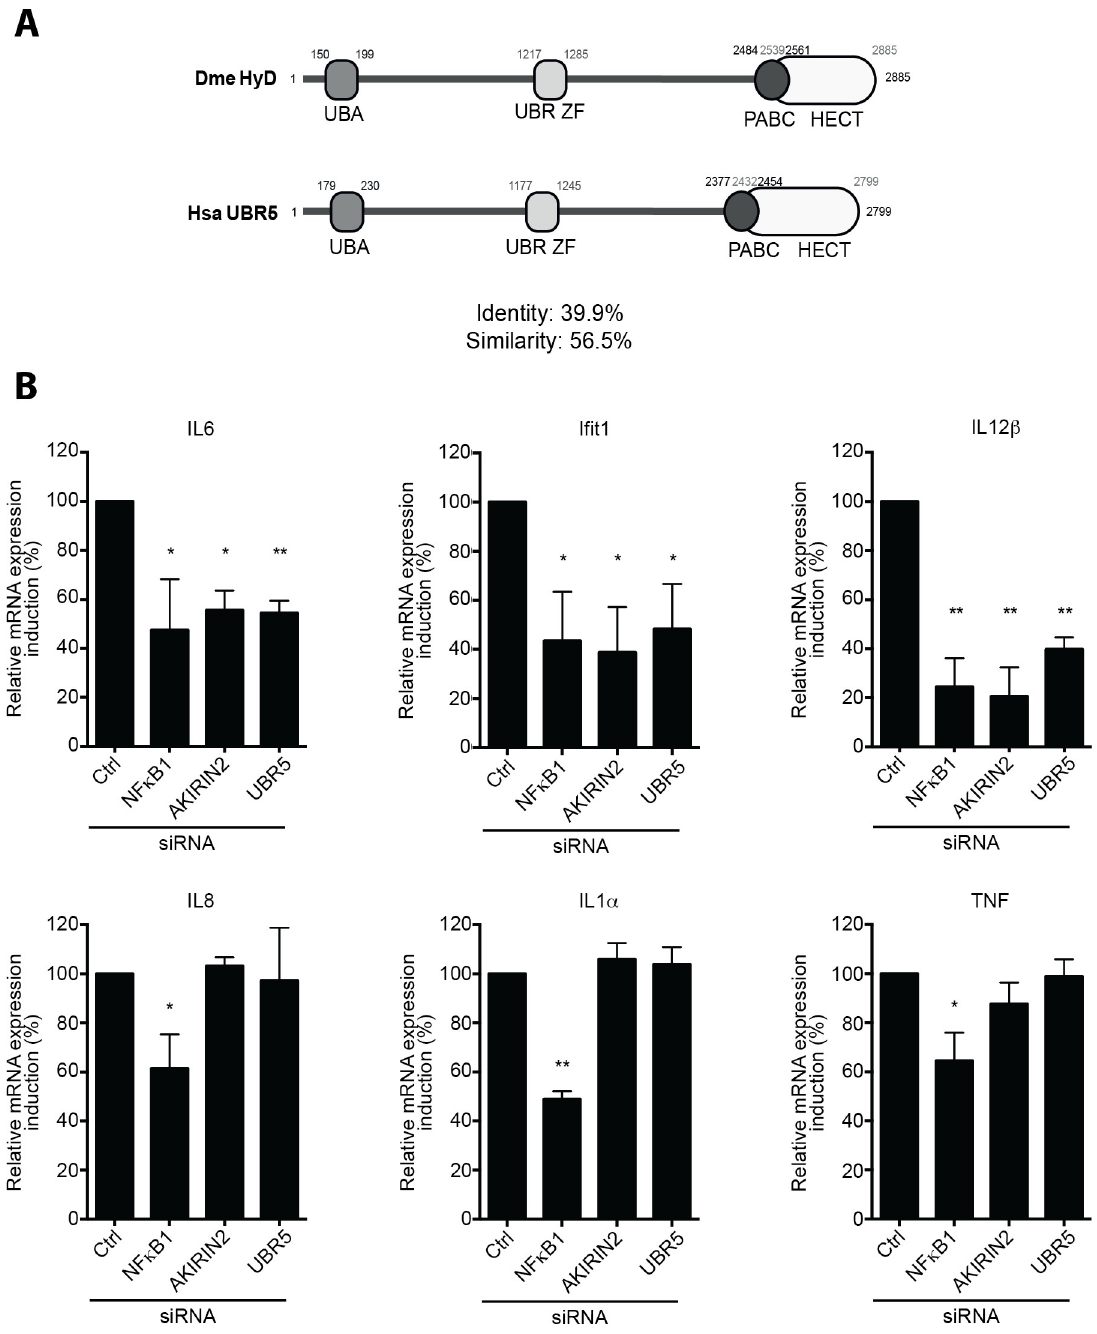
Fig 4. Hyd/UBR5 is necessary for NF- κ B target genes activation. ( A ) Graphical representation of the predicted functional domains of Drosophila melanogaster Hyd and Homo sapiens UBR5. This representation highlights a conserved Ubiquitin-associated (UBA) domain, poly(A)-binding protein C-terminal (PABC) domain, Homologous to the E6-AP Carboxyl Terminus (HECT) domain and UBR type Zinc Finger (UBR ZF) domain. Annotation based InterPro software. Sequence similarity percentages calculated using the EMBOSS NEEDLE tool (default settings). ( B ) Quantitative RT-PCR of IL6 , Ifit1 , IL12 β , IL8 , Il1 α and TNF mRNA from LPS-stimulated THP1 cells. They were transfected with scrambled siRNA (negative control) or siRNA targeting NF- κ B1 , AKIRIN2 (positive controls) or UBR5 . Data are represented as mean ± standard deviation of three independent experiments. After the ratio of stimulated over unstimulated values for each condition was determined, statistical significance was established by comparing genes knockdown with scrambled siRNA control. � P-value < 0.05; �� P-value < 0.01; ��� P-value < 0.001.